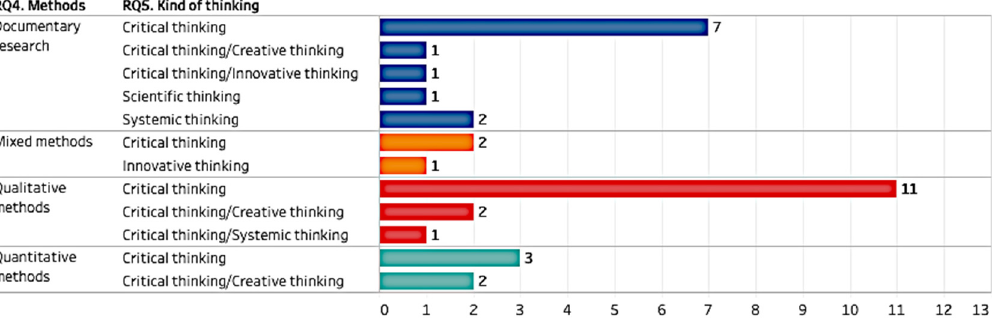
Figure 5. Methods and kind of thinking reflected in the papers.